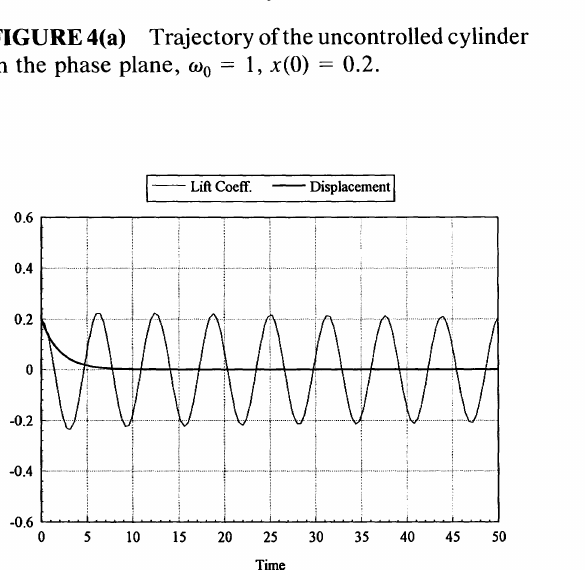
FIGURE 4(a) Trajectory ofthe uncontrolled cylinder in the phase plane, Wo = 1, x(O) = 0.2.